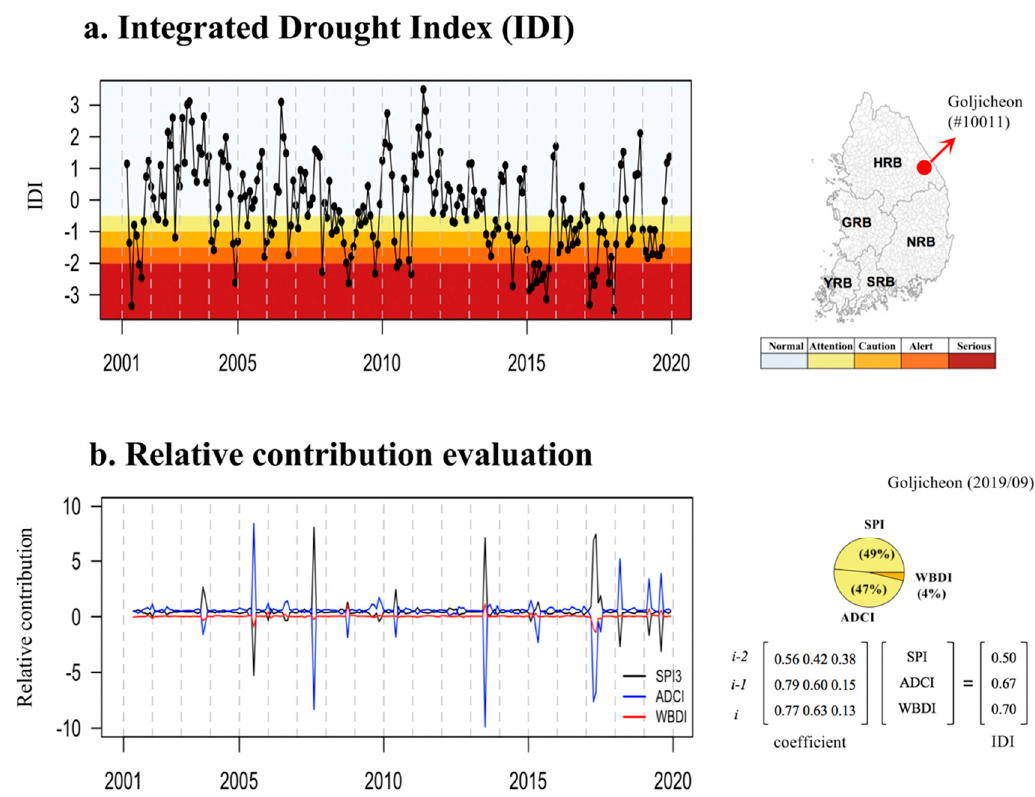
Figure 4. Time series of integrated drought index (IDI) for 2001–2019 in the Gojicheon stream in the Han River basin. ( a ) IDI index and ( b ) relative contribution evaluation.